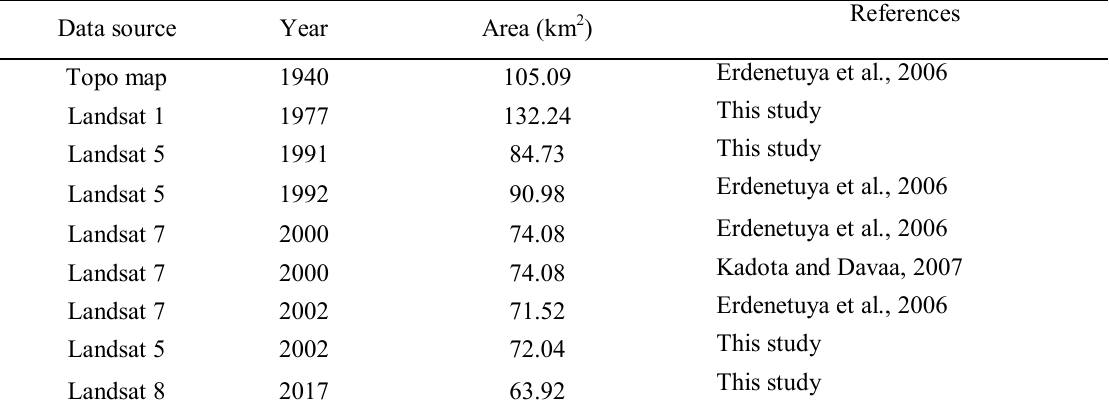
Table 2. Changes in area of the modern glacier in Mt. Tsambagarav over the last seven